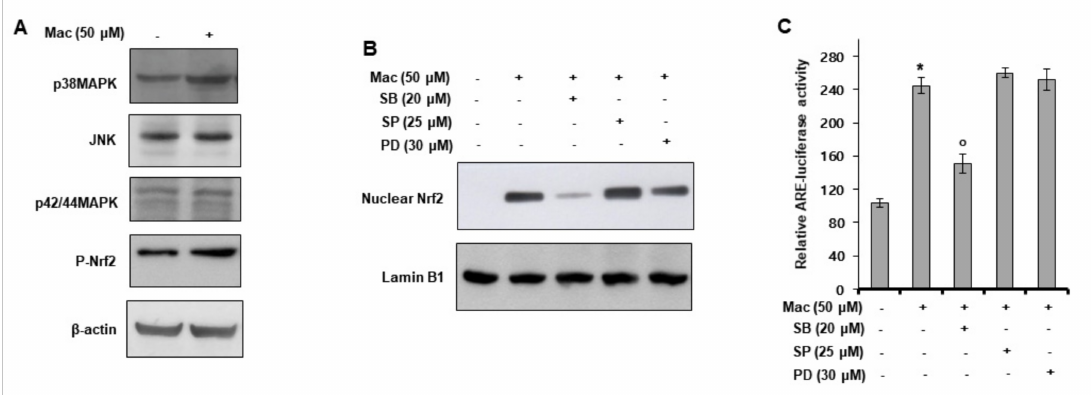
Figure 5. Maclurin-induced Nrf2 activation is mediated by p38 MAPK activation. ( A ) HaCaT cells were treated with maclurin for 1 h and analyzed by Western blots. ( B ) HaCaT cells were treated with maclurin and SB203580, SP600125, or PD98059 for 24 h and analyzed by Western blotting of the cytosolic and nuclear fractions to assess Nrf2 translocation. ( C ) HaCaT cells were transfected with the ARE-Luc reporter using the DharmaFECT ® Duo transfection reagent. After 24 h incubation, the cells were treated with maclurin in the presence of SB203580, SP600125, or PD98059 for 14 h. The cells were lysed and analyzed by the luciferase reporter assay. The data are shown as the mean ± SD of three replicates. * p < 0.05 vs. untreated control, o p < 0.05 vs. maclurin-treated control. Mac: